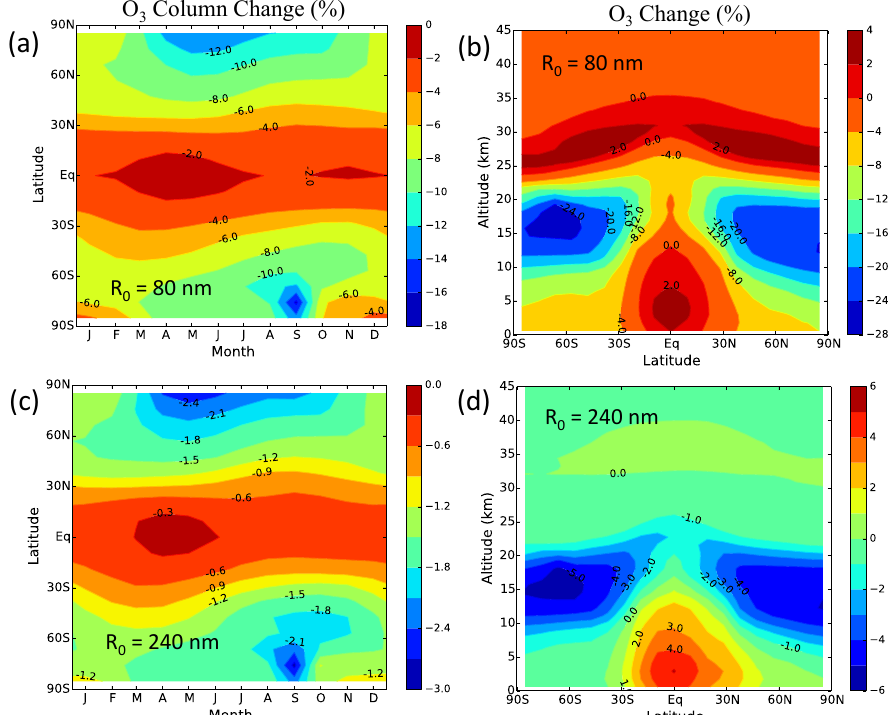
Figure 11. Ozone changes due to the injection of alumina aerosol. Column ozone changes (%) are shown as a function of latitude and month (left panels) and annual average local ozone changes (%) as a function of latitude and altitude (right panels). Results are shown for an injection rate of 1Tgyr − 1 of 80nm (top panels) and 240nm (bottom panels) alumina monomers. Note ozone increases in the upper stratosphere where the NO x cycle dominates, and decreases in the lower stratosphere where the ClO x and BrO x cycles